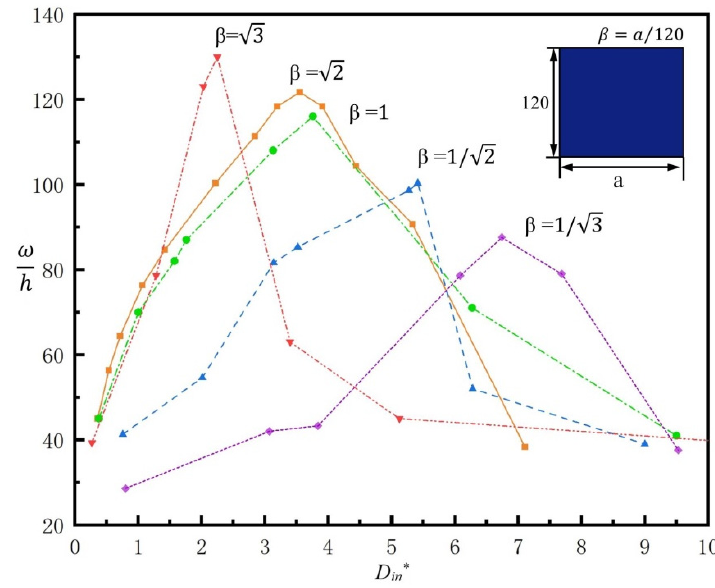
Figure 12. The variation of deflection of anisotropic box structure with 𝐷 (cid:3036)(cid:3041)∗ .